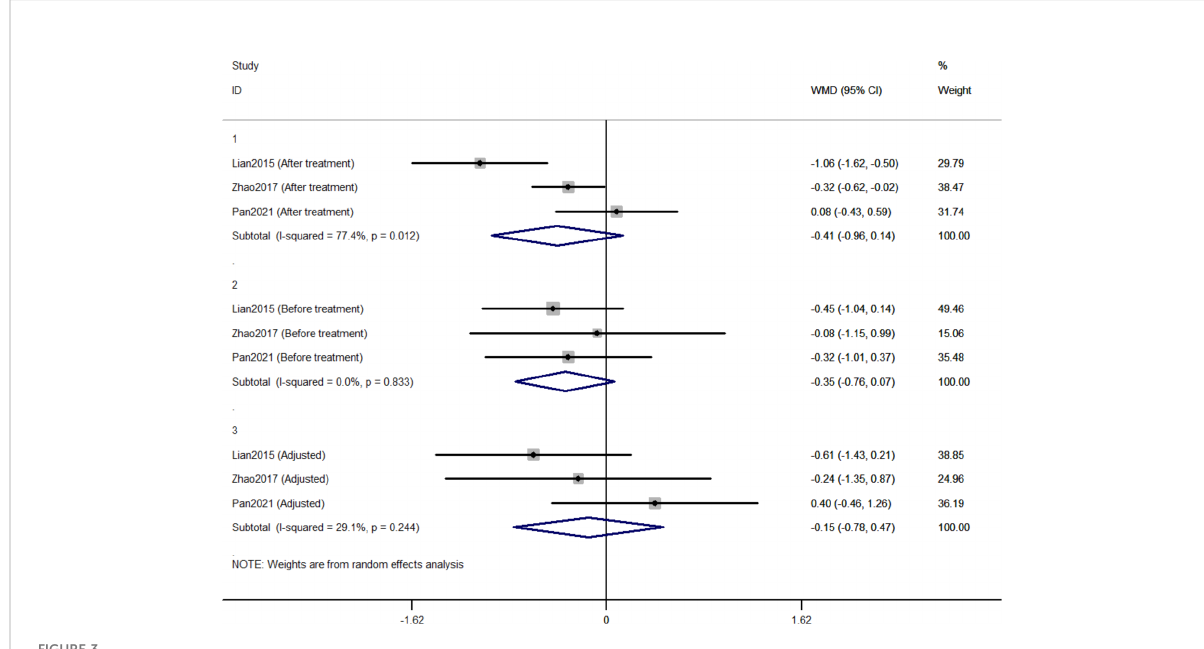
FIGURE 3 Forest plots of changes in FPG between Jinlida Groups and Control Groups.